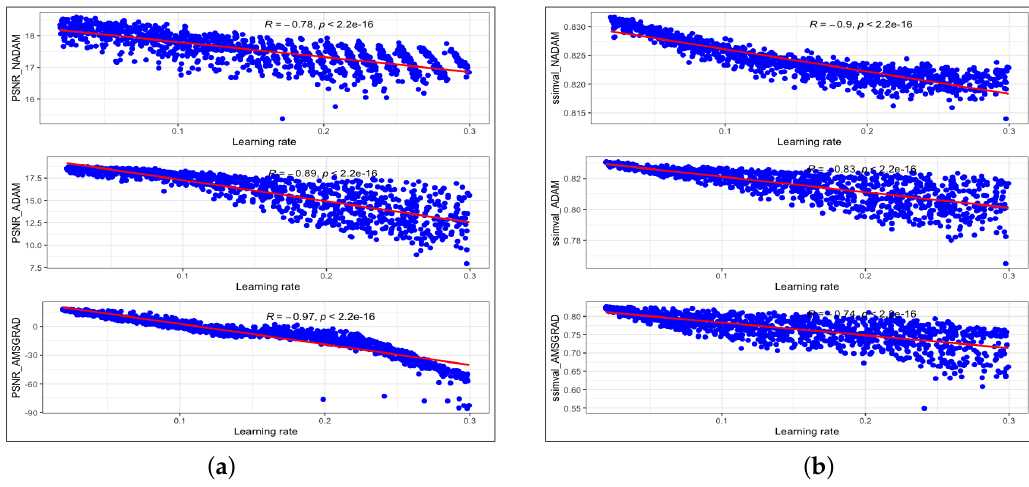
Figure 8. Correlation between learning rate and ( a ) PSNR and ( b ) SSIM for different optimizers. The resulting Spearman’s coefficient R and the p -value are shown at the top of each graph.